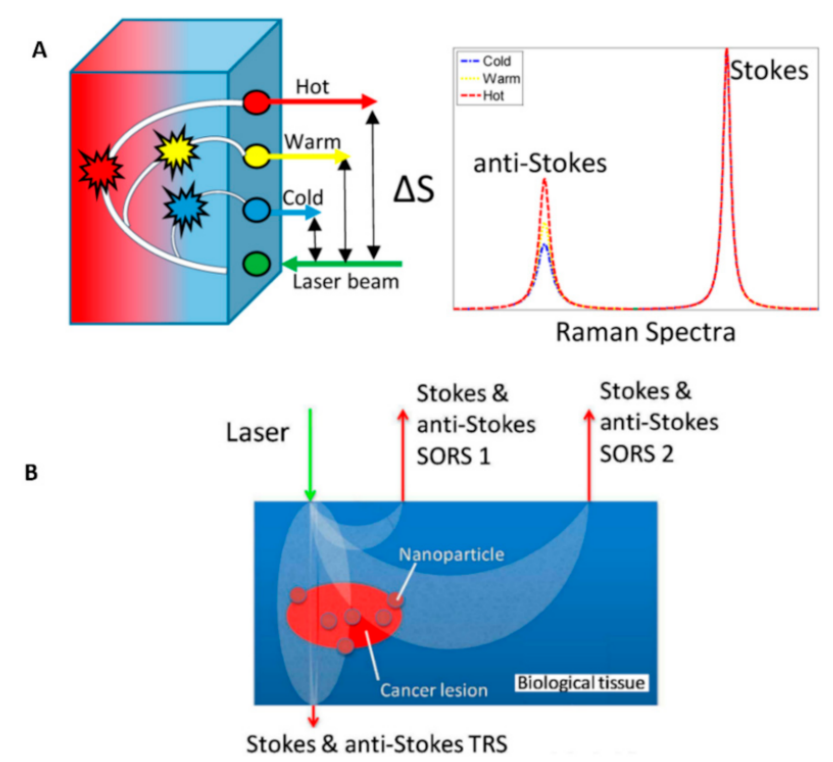
Figure 10. ( A ) Concept of T-SORS showing a cold surface and warm interior; as the spatial offset between the illumination point and collection point increases, there is a relative increase in the anti-Stokes contribution in the spectra originating from the warmer sublayer. ( B ) Schematic diagram of T-SESORS thermometry. The SORS and TRS geometries permit subsurface sample temperature monitoring mediated by SERS nanoparticles embedded in a turbid medium. The temperature of nanoparticles can also be elevated above background levels and monitored using laser radiation. Adapted with permission from